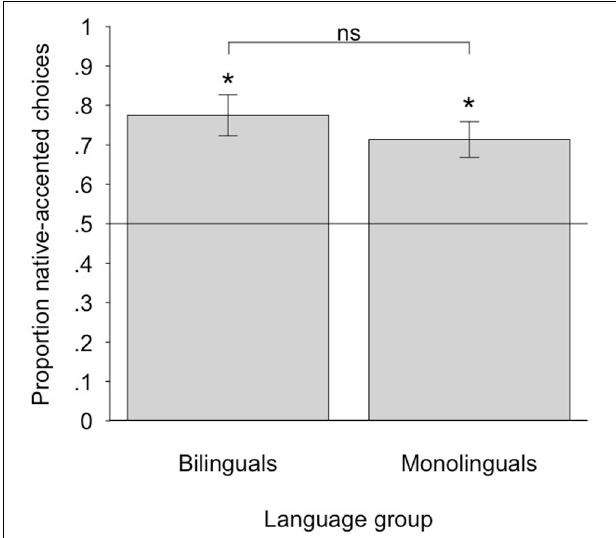
FIGURE 1 | Children’s preference for native-accented speakers as a function of language group. Error bars show the standard error of the mean. ∗ p < 0 . 001.